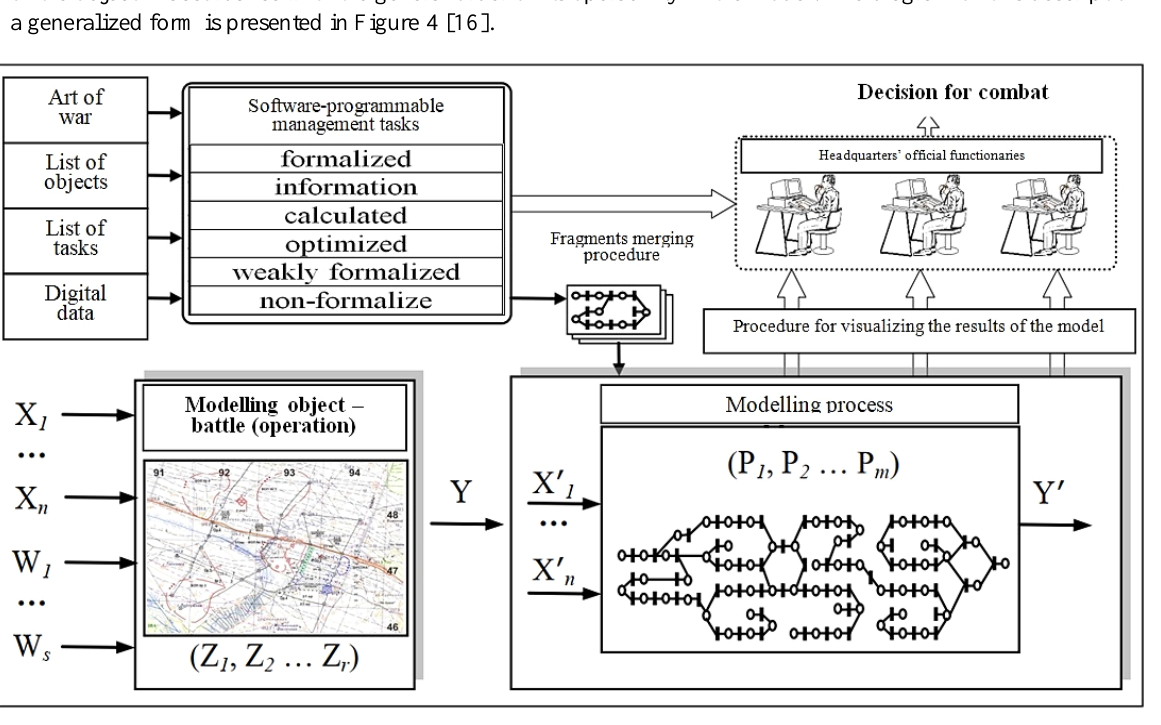
Figure 4. Block schematic diagram of the description of the model of combat